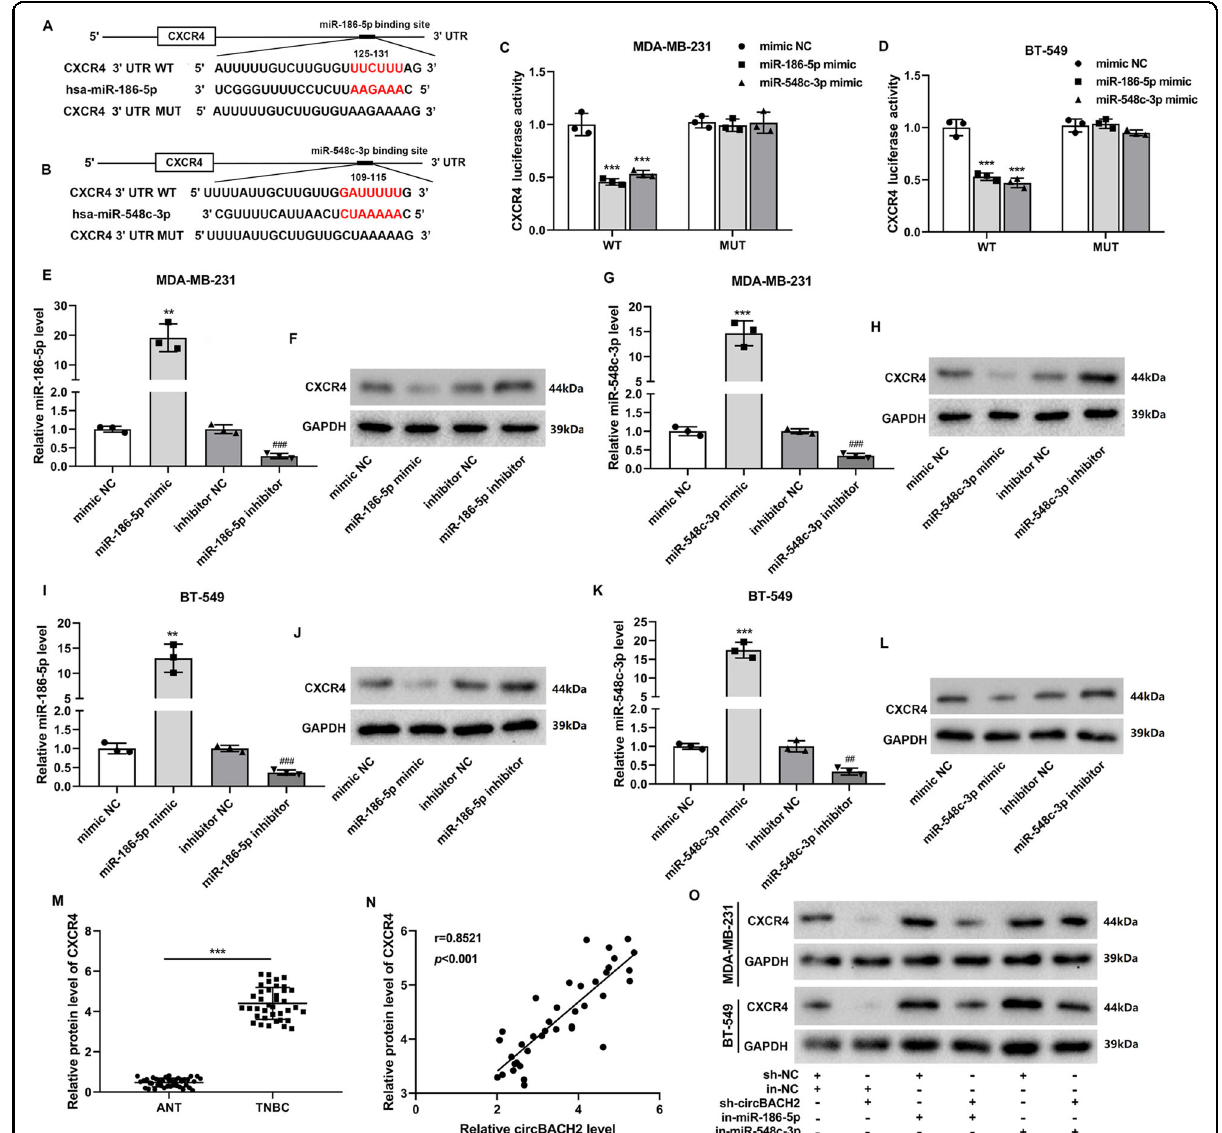
Fig. 6 C-X-C chemokine receptor type 4 (CXCR4) was the downstream target of miR-186-5p and miR-548c-3p. A , B The predicted binding sites between miR-186-5p/miR-548c-3p and CXCR4 mRNA. C , D The luciferase reporter assay was performed in MDA-MB-231 and BT-549 cells that were co-transfected with CXCR4 WT/MUT luciferase vector and miR-186-5p mimic/miR-548c-3p mimic/mimic NC. E – L MDA-MB-231 and BT-549 cells were transfected with miR-186-5p/miR-548c-3p mimic or miR-186-5p/miR-548c-3p inhibitor or corresponding negative controls (mimic NC or inhibitor NC). The expression levels of miR-186-5p/miR-548c-3p were measured by RT-PCR. The protein level of CXCR4 was measured by western blot. GAPDH was used as an internal control. M The protein level of CXCR4 was measured in TNBC cancerous tissues ( n = 38) and ANT ( n = 38). *** P < 0.001. N The correlation plot of circBACH2 level and CXCR4 protein level in TNBC cancerous tissues ( n = 38). O MDA-MB-231 and BT-549 cells were divided into six groups: sh-NC + inhibitor NC (in-NC), in-NC + sh-circBACH2, sh-NC + in-miR-186-5p, sh-circBACH2 + in-miR-186-5p, sh-NC + in-miR- 548c-3p, and sh-circBACH2 + in-miR-548c-3p. The protein level of CXCR4 was measured by western blot. GAPDH was used as an internal control. ** P < 0.01, *** P < 0.001 vs mimic NC; ## P < 0.01, ### P < 0.001 vs inhibitor